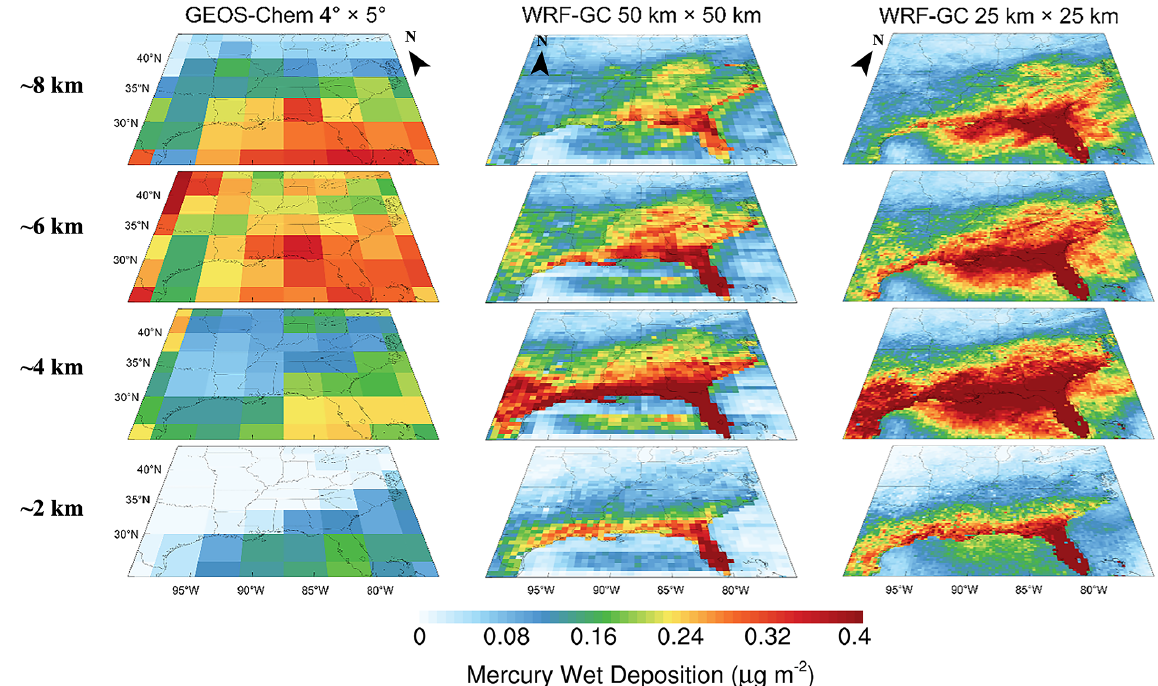
Figure 8. Comparison of total Hg wet deposition of GEOS-Chem and WRF-GC at different levels and resolution. From top to bottom: the simulation results for the ∼ 2km, ∼ 4km, ∼ 6km, and ∼ 8km level, respectively. The first column is GEOS-Chem 4 ◦ × 5 ◦ simulation results. The other two from left to right correspond to different WRF-GC resolutions: 50km × 50km and 25km ×